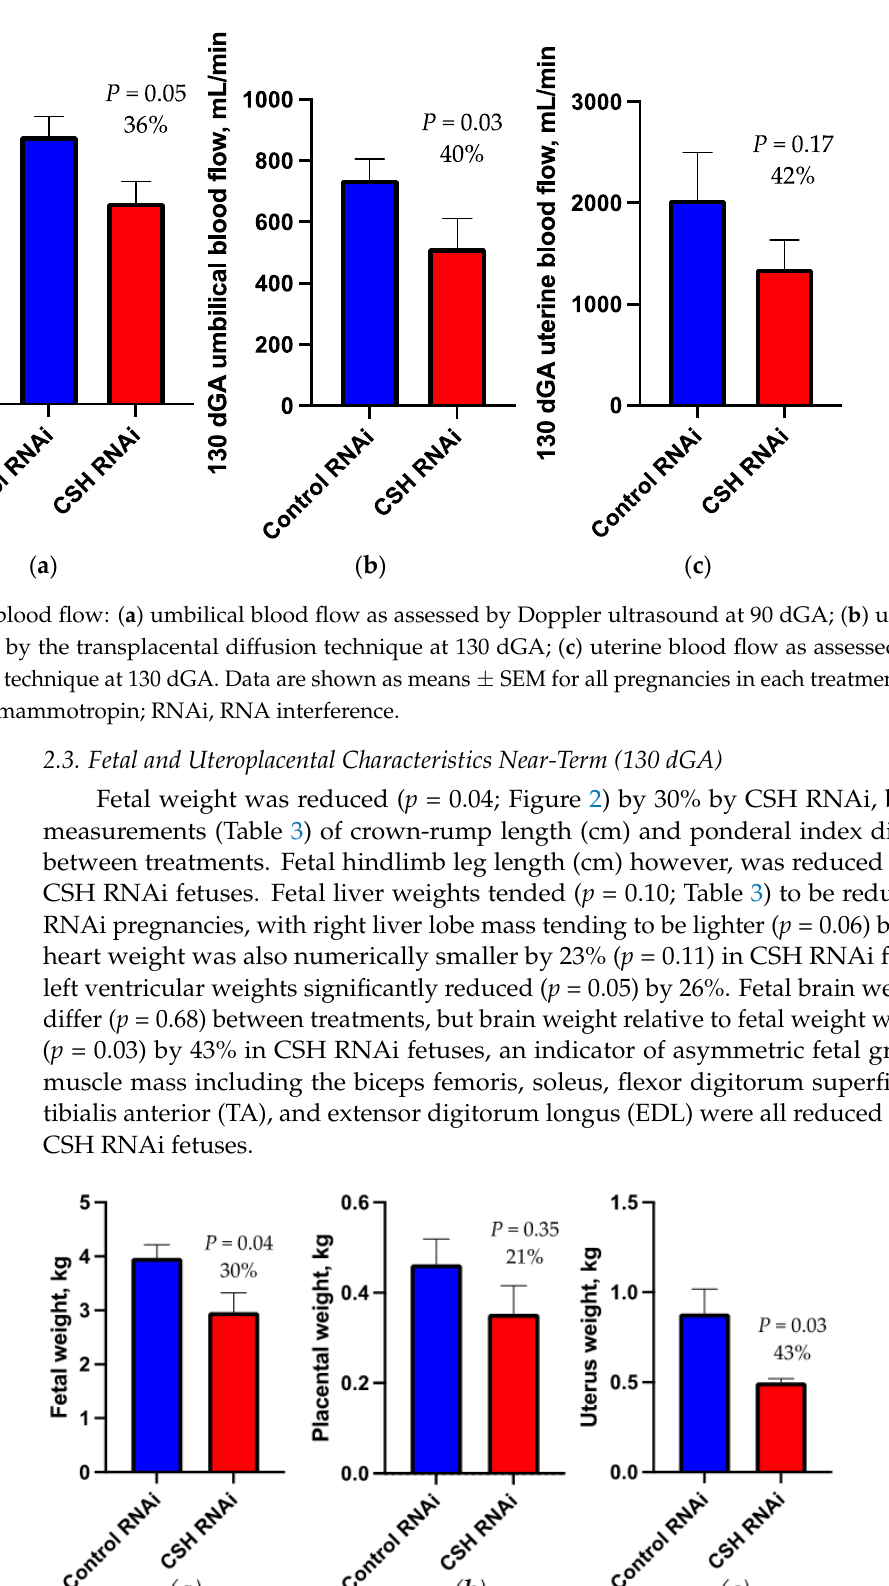
Figure 2. Measures of fetal and uteroplacental mass at 130 dGA: ( a ) fetal weight in kg ( b ) placental weight in kg; ( c ) uterus weight in kg. Data are shown as means ± SEM for all pregnancies in each treatment group. CSH, chorionic somatomammotropin; RNAi, RNA interference. Table 3. Fetal weights, growth parameters, and uteroplacental characteristics assessed at necropsy (130 dGA). CON RNAi CSH RNAi